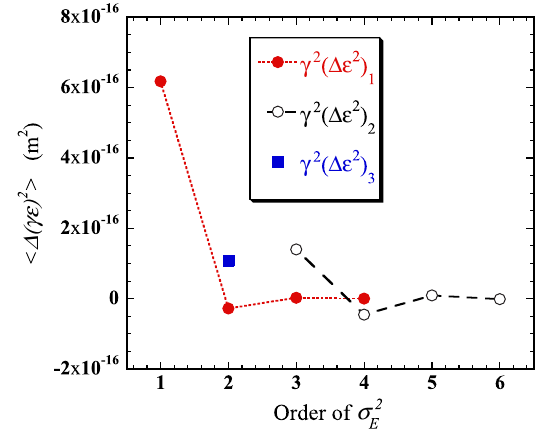
FIG. 1. Contribution of each order of (cid:7) 2 to expected growth of square of normalized emit- and ð (cid:2) (cid:3) 2 Þ 3 tance [ hð (cid:4)(cid:3) Þ 2 i ], with BPM offset error 50 (cid:10) m (rms) after one to one correction in the ILC main linac.